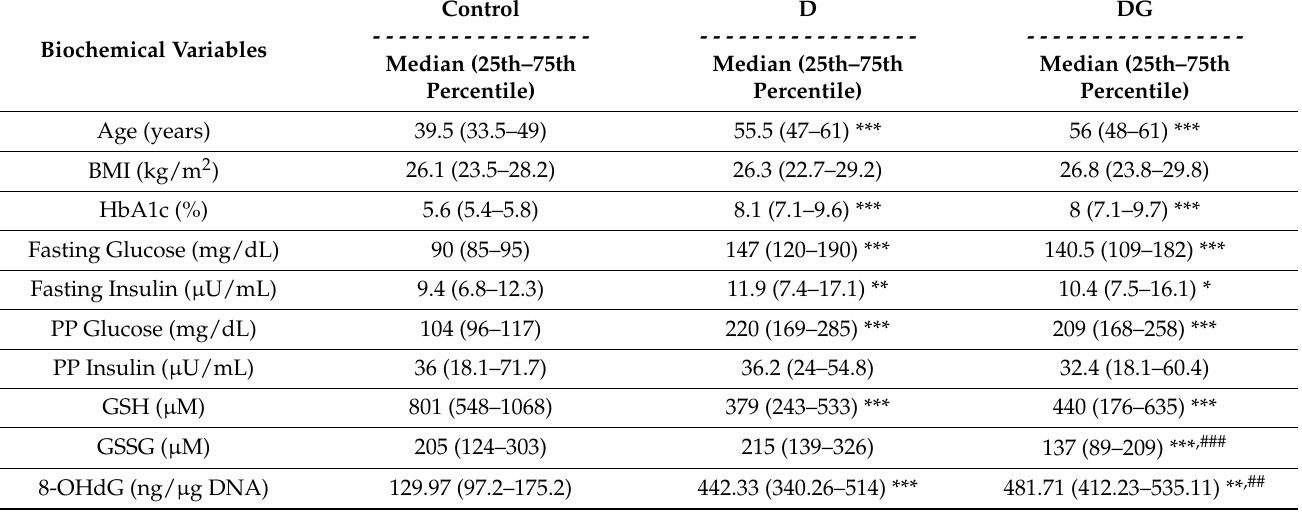
Table 1. Baseline characteristics of Control, D, and DG groups. Data from each group at the α visit are presented here as median and IQR, inter-quartile ranges (25th percentile–75th percentile). * indicates the significance of the comparison between baseline measurements of Control versus D or Control versus DG groups. Significance levels are * p < 0.05, ** p < 0.01, and *** p < 0.001. Similarly, significance levels for comparisons between D versus DG groups are denoted with ## , or ### for p < 0.05, p < 0.01, and p < 0.001, respectively. We did not observe any significant differences in the levels of FPG, PPG, FPI, PPI, HbA1c, and GSH within the D and DG groups, thus confirming covariate balance in the two groups at baseline (Table S4). Abbreviations used here are BMI—body mass index, HbA1c—glycated hemoglobin, GSH—reduced glutathione, PP